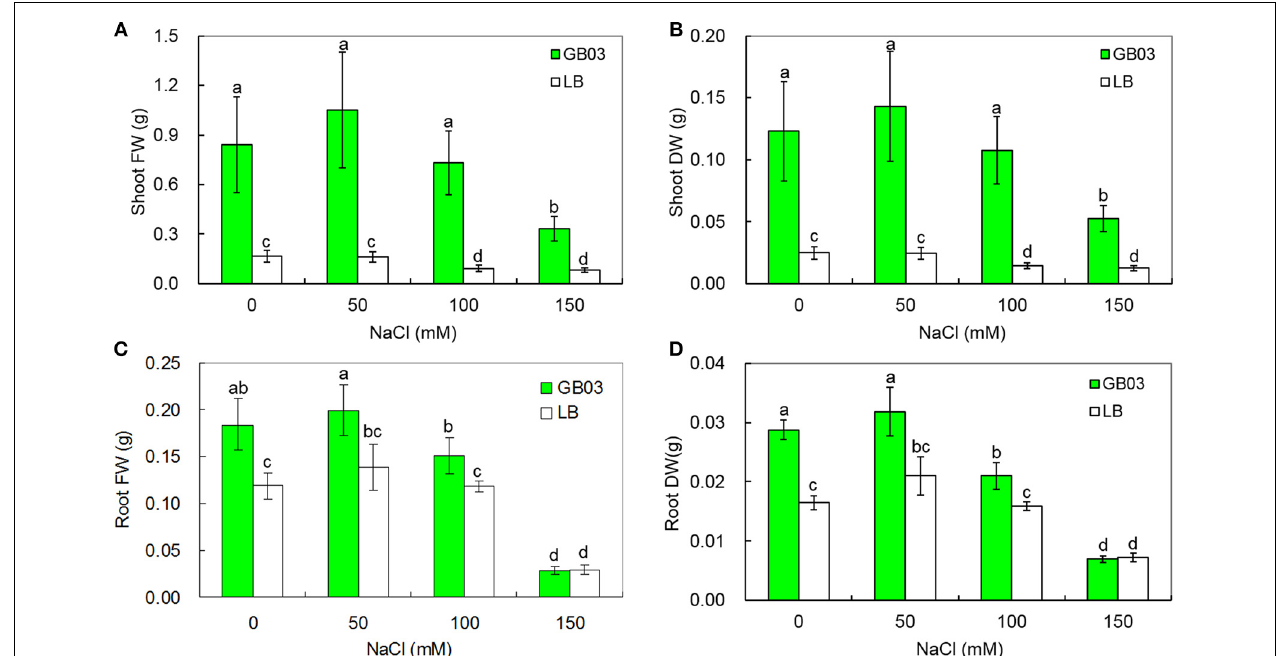
dry weight. Values are means and bars indicate SDs ( n = 8). Columns with different letters indicate significant difference at P < 0 . 05 (Duncan